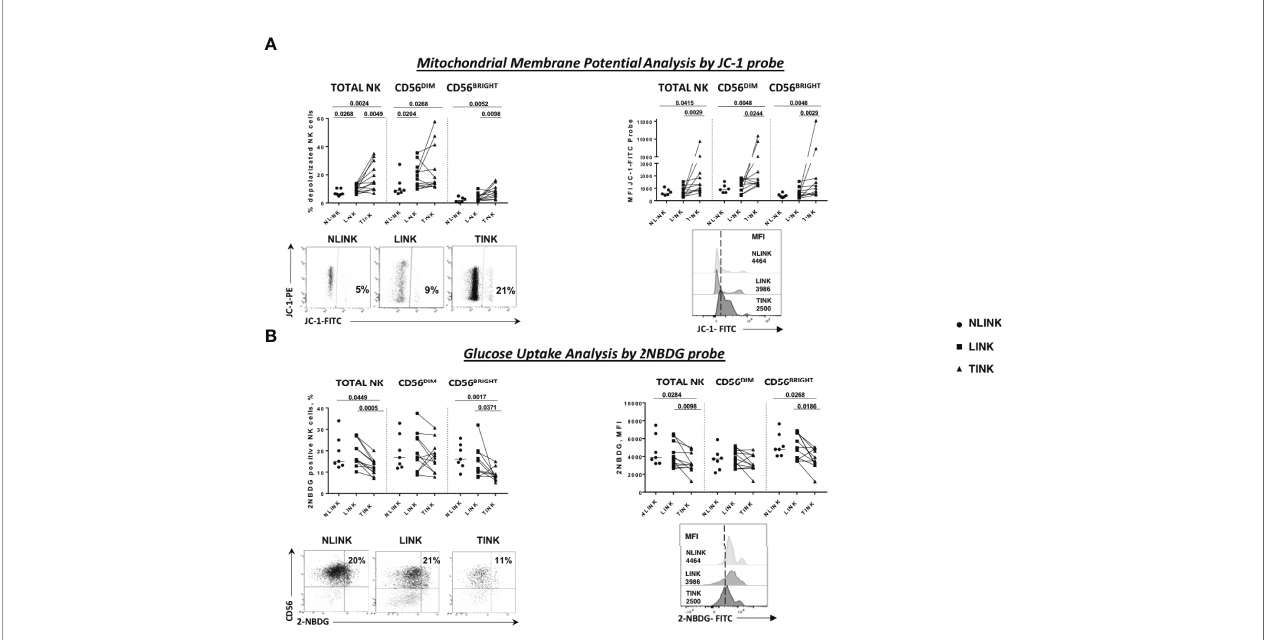
FIGURE 2 | Metabolism assessment of in fi ltrating NK cells. (A) Mitochondrial membrane potential measured by the potentiometric probe JC-1. After anti-CD3 and anti-CD56 staining, JC-1 was added to NK cells from the three compartments: NLINK ( n = 7), LINK ( n = 12), and TINK ( n = 12). Afterwards, the cells were stained with 7-AAD for viability and then analyzed on a fl ow cytometer. Depolarized NK cells (upper left panel) were quanti fi ed by the percentage of FL1high/FL2low cells (JC-1 staining) detected in the different samples. Median fl uorescent intensity (MFI) of JC-1 in the FITC channel were analyzed in all study groups in the NK cells subsets (TOTAL, CD56 DIM , and CD56 BRIGHT ). In the lower panels, representative examples of the two analyses. (B) Glucose uptake assay was performed on LINK ( n = 12), NLINK ( n = 7), and TINK ( n = 12). The cells were stained with the glucose analog 2-NBDG. The frequency of 2-NBDG-positive NK cells was evaluated (upper left panel) as well as the MFI of the probe (upper right panel). Representative dot plots and histograms show the 2-NBDG uptake in NK cells. Statistical analysis was performed by Wilcoxon matched pairs test (LINK vs . TINK) and Mann Whitney test (NLINK vs . TINK and NLINK vs . LINK). Horizontal lines represent median